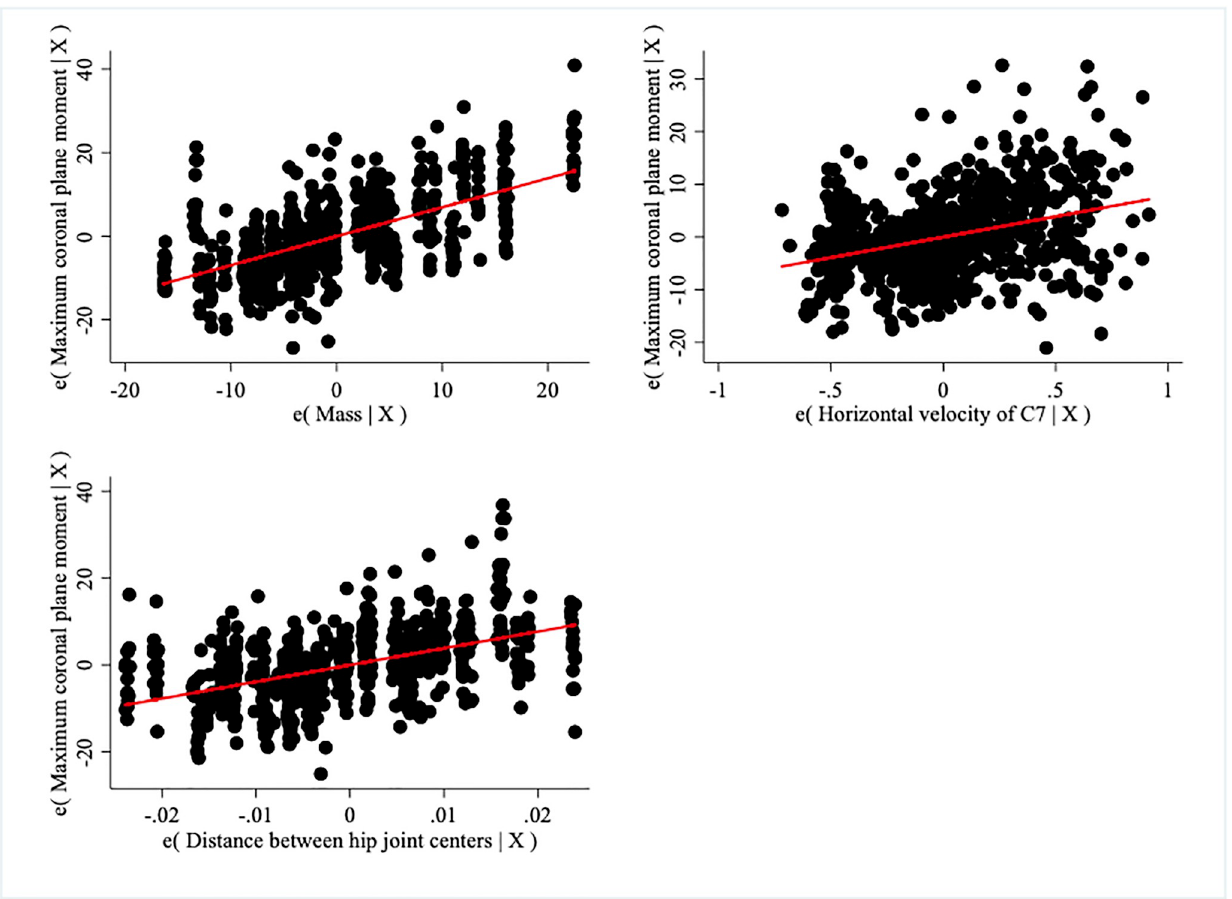
Fig 3. Contribution of mass, horizontal velocity of C7, and functional distance between hip joint centers to the prediction of maximum hip coronal plane moment when the effect of other variables is controlled. Sometimes called added variable or partial regression (leverage) plots, each panel demonstrates the effect of one independent variable (either mass, velocity, or distance) on the dependent variable when the effects of the other two independent variables are accounted